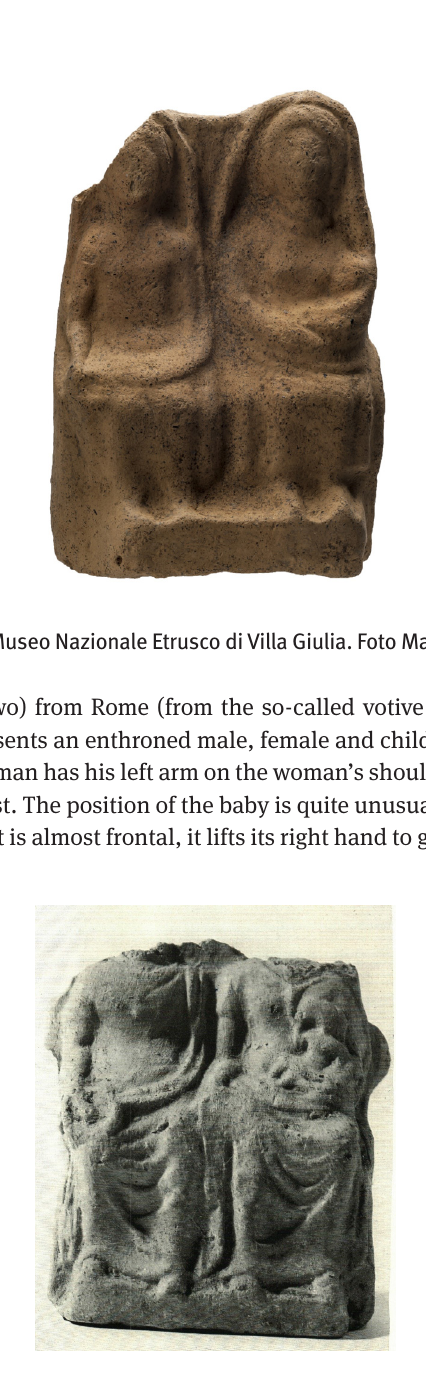
26 Recently, scholars have identified the shrine linked with this deposit with the temple of Fortuna Virgo . See infra